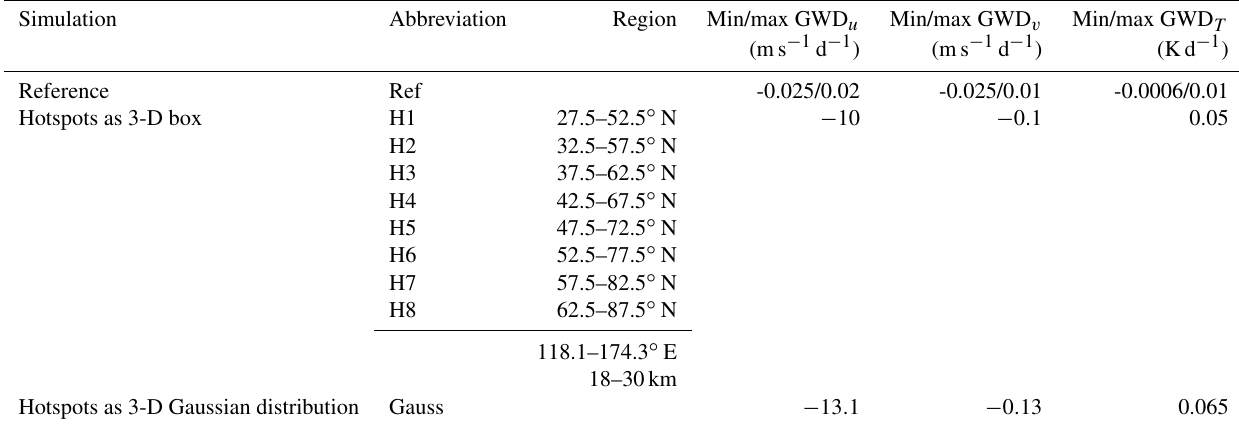
Table 1. Overview of the mean and maximum values of the zonal and meridional GW drag and heating by GWs for the reference and hotspot simulations as a 3-D box (H1–H8) and as a Gaussian distribution (Gauss). The mean and maximum values refer to the region (118.1–174.3 ◦ E, 18–30km and the respective latitude range as listed below) of the